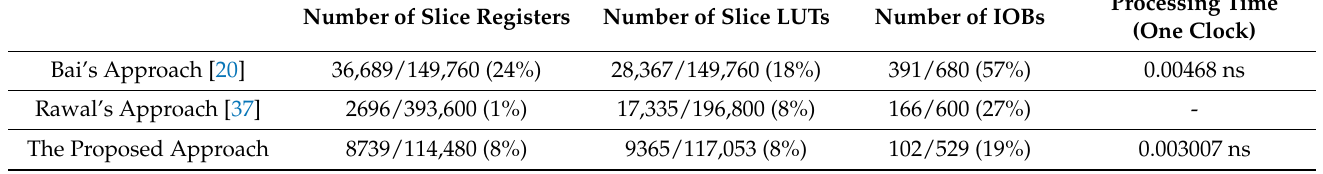
Table 3. Comparison of Hardware Resource Utilization of Xilinx (Proposed Tracking Approach).